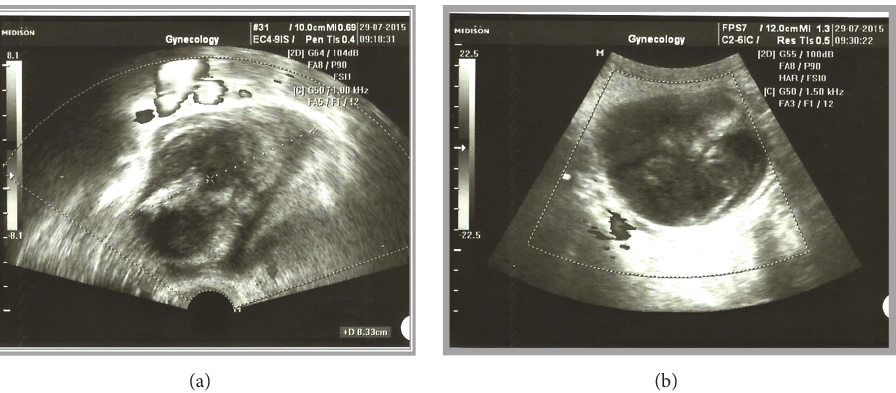
Figure 1: Transvaginal ultrasound showed a cystic formation sized 83 × 65 × 64 mm in the right adnexal area with signs of necrosis.